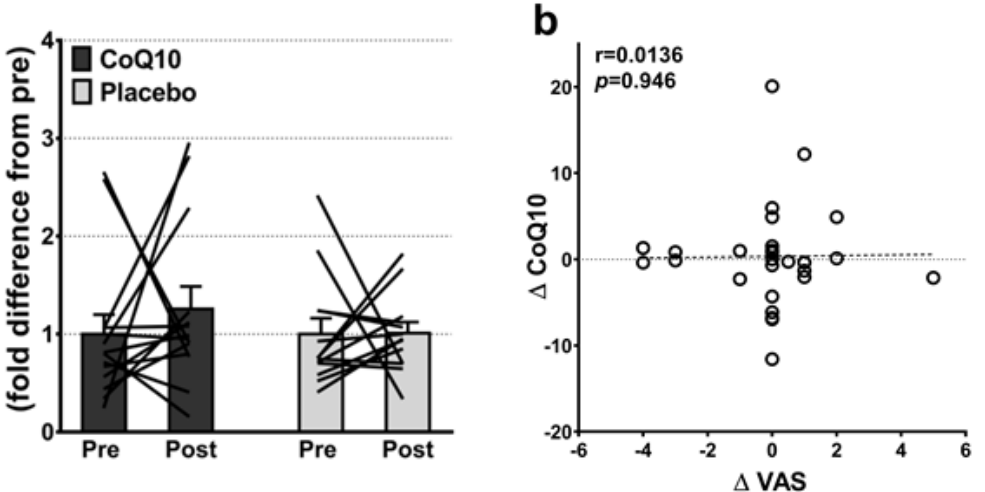
Figure 2. ( a ) Intramuscular CoQ10 levels pre and post CoQ10 and placebo supplementation (n: CoQ10 = 14, placebo = 13). The lines shows pre and post measurements in each individual. ( b ) Correlation between changes in individual pain perception ( ∆ VAS) and individual changes in intramuscular CoQ10 levels ( ∆ CoQ10) (n = 27). Error bars on “Pre” are SEM of fold difference from the mean.